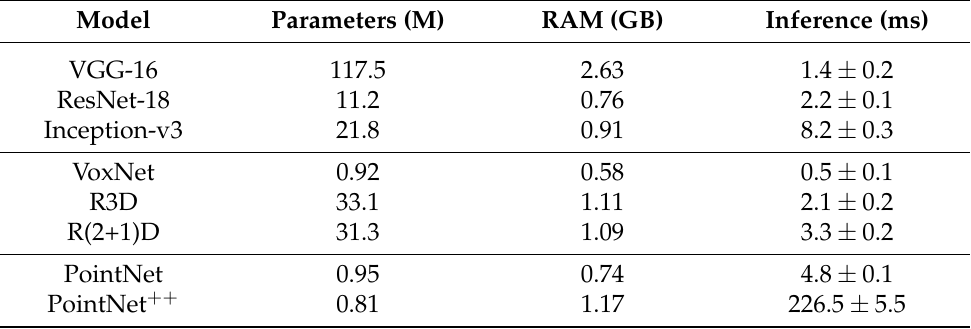
Table 8. A comparison of the computational complexity of different methods. We report the number of parameters, the amount of memory (RAM), and the inference time that isrequired by the models, implemented in